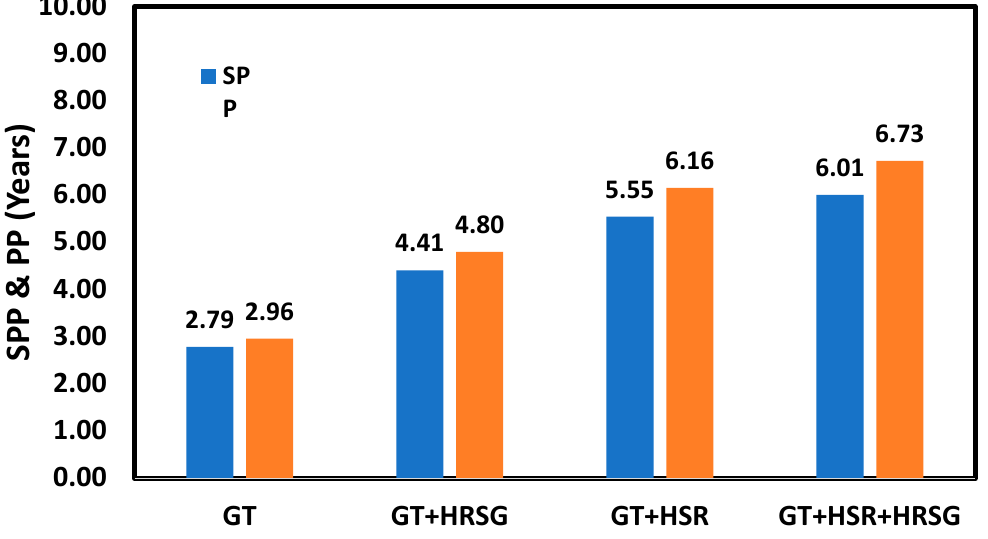
Figure 14. Simple payback period (SPP) for four types. Appl. Sci. 2020 , 10 , x FOR PEER REVIEW